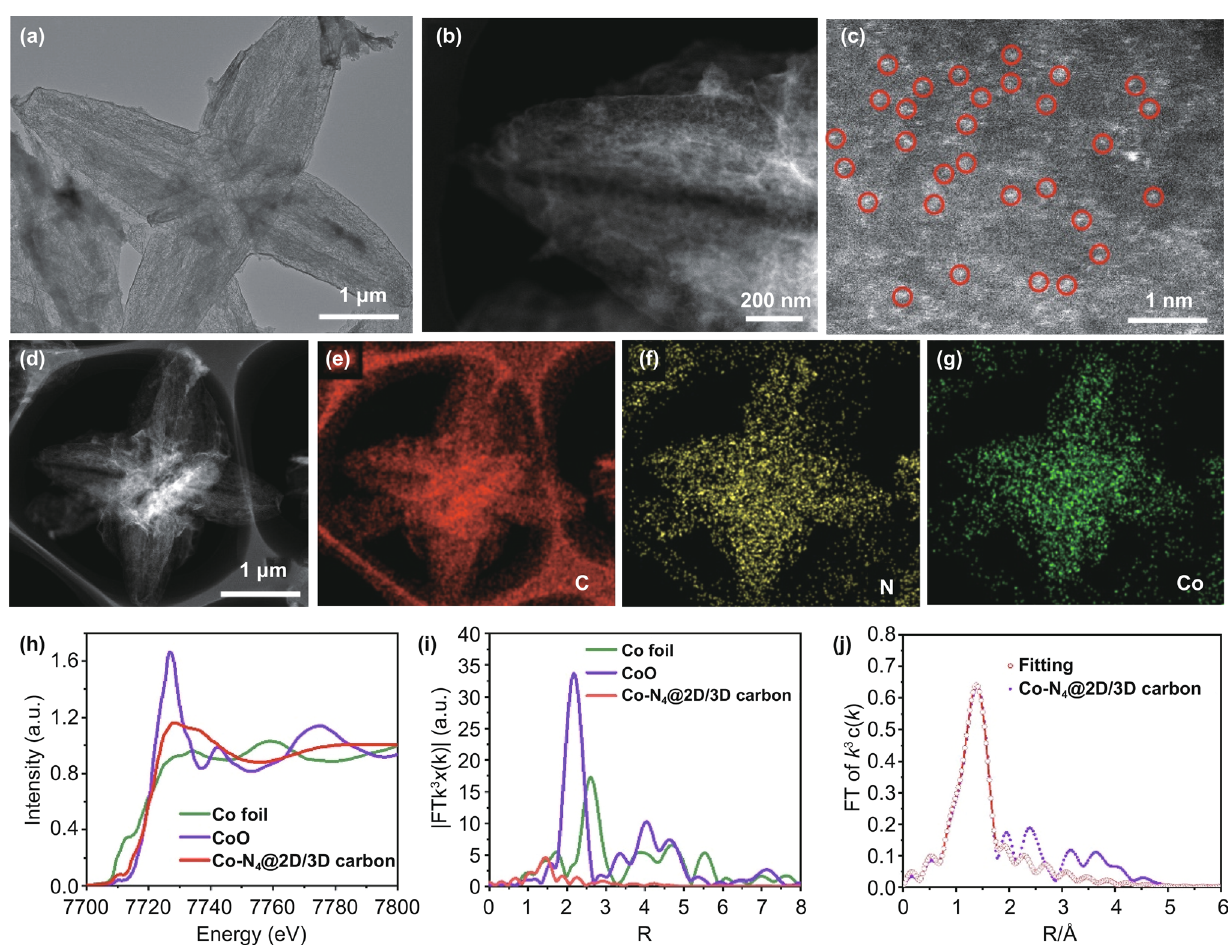
Fig. 2 a TEM image, b–d HAADF-STEM images of Co–N 4 @2D/3D carbon and e–g corresponding element mapping of C, N and Co in Co–